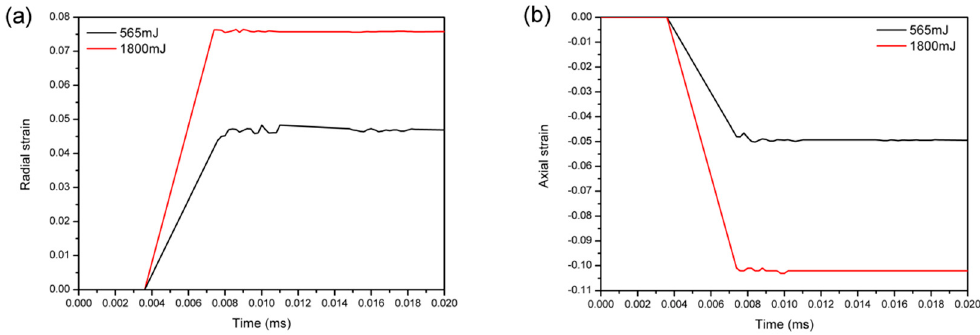
Figure 31. Time ‐ varying curves of the strain distribution at the bar corner region under the laser energy of 565 mJ and 1800 mJ: ( a ) radial strain distribution and ( b ) axial strain distribution.